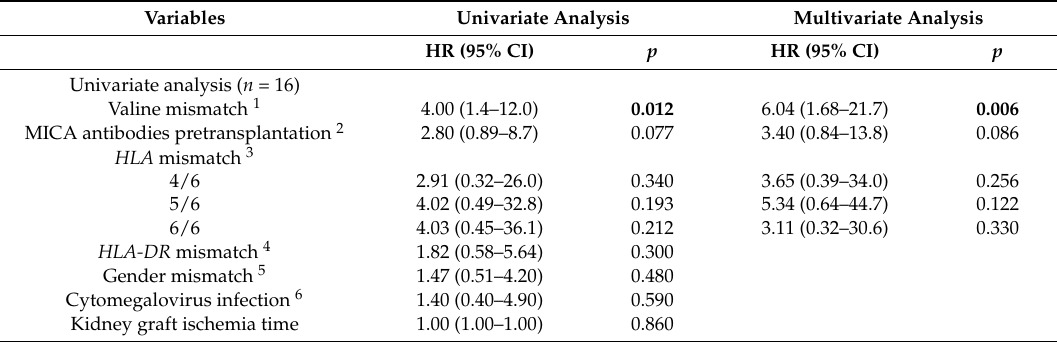
Table 3. Univariate and multivariate Cox regression analyses of predictor variables in SPKT patients with acute kidney